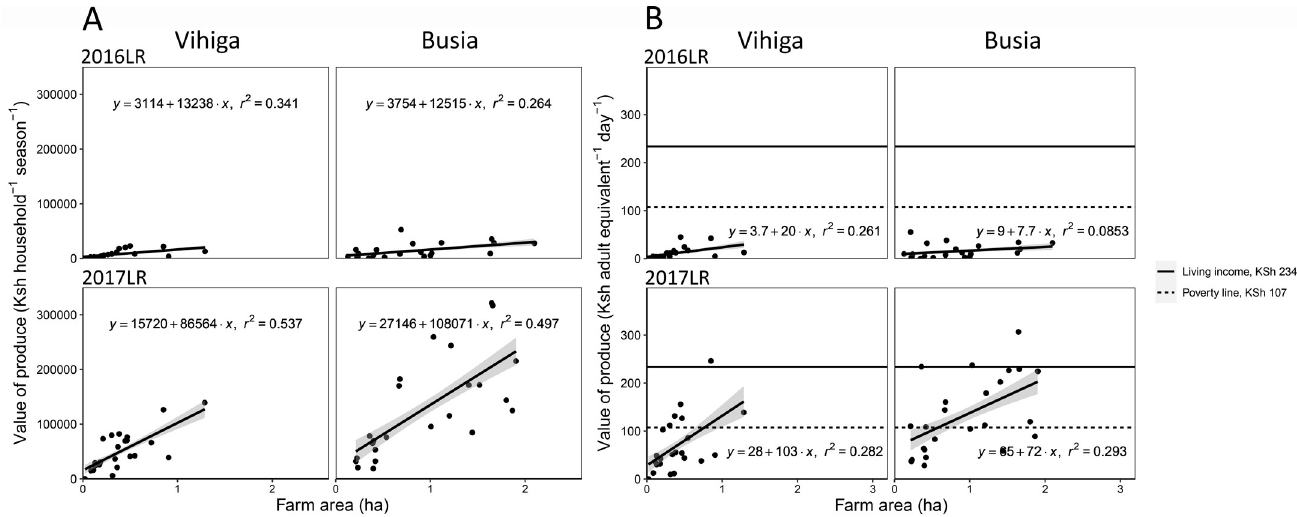
Fig 4. Total value of produce in Kenyan Shilling (KSh) per household per season (A) and the value of produce per adult equivalent per day (B) in relation to farm area during the long rains (LR) cropping season before the programme (2016) and during the programme (2017).